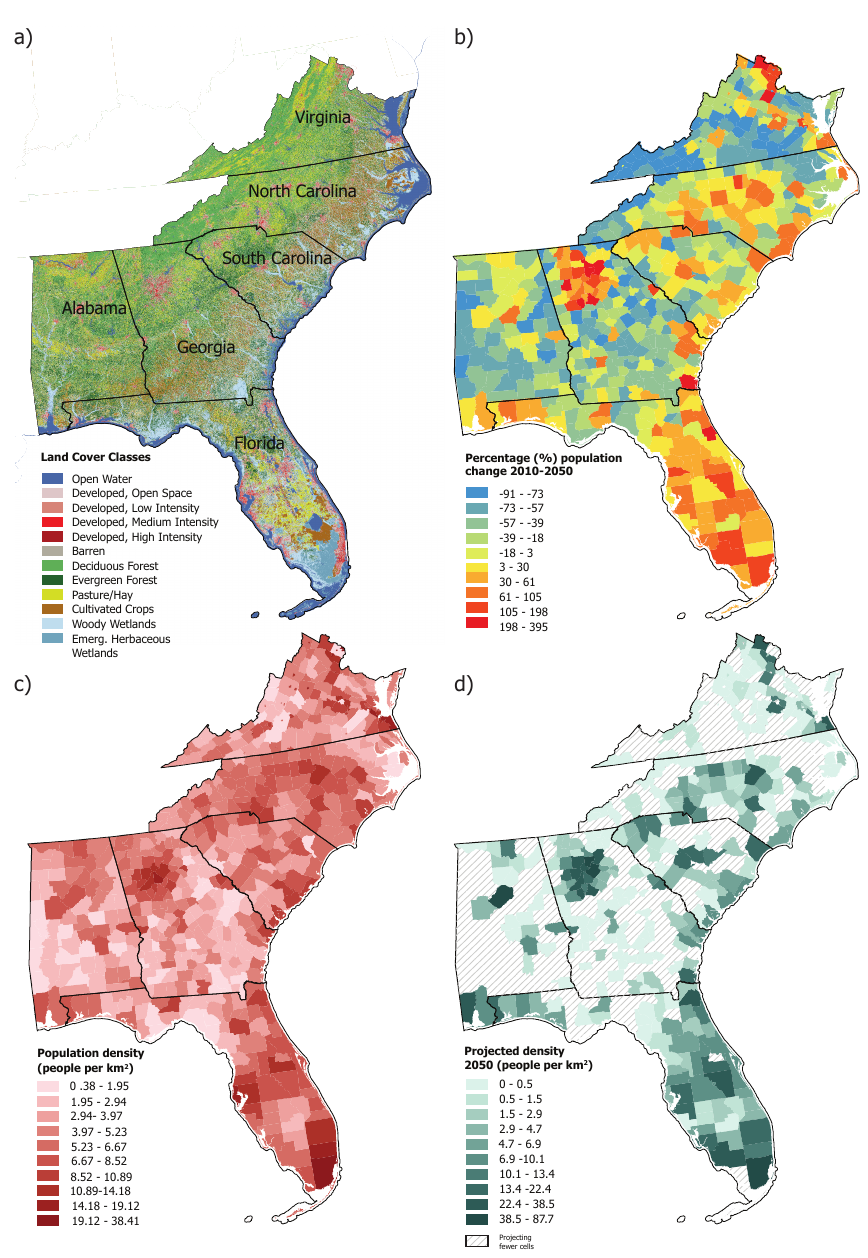
Figure 1. Maps of ( a ) Land cover [32], ( b ) percentage change in population from 2010-2050 [29], ( c ) population density (urban impervious/population) 2010, and ( d ) projected population density based on Integrated Climate and Land-Use Scenarios population scenarios [33] and a logarithmic growth curve (see Section